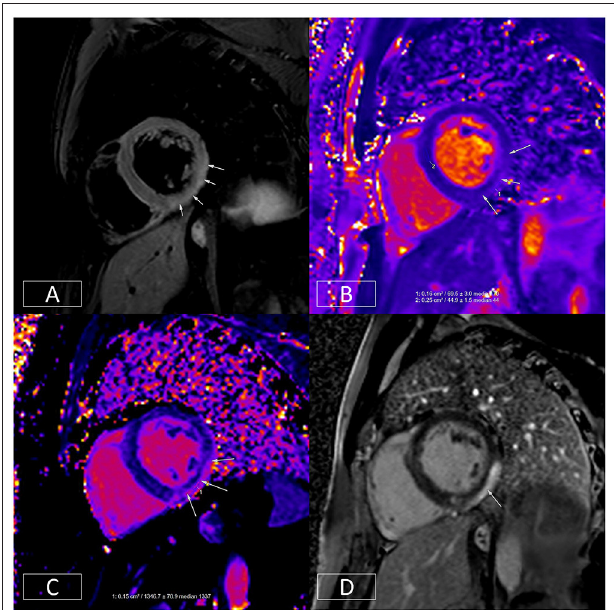
FIGURE 5 | Multiparametric evaluation of a patient with acute myocarditis. (A) Depicts increased T 2 signal in the mid-inferior and lateral walls in an epicardial to mid-wall distribution. The absolute T 2 time in the inflamed area is increased to ∼ 70ms (B) whereas the remote myocardium in the septum has a normal T 2 time of 45ms (normal < 55ms). (C) depicts increased native T 1 , another marker of tissue injury. This is raised at 1,347ms in the epicardium of the mid-inferior and lateral walls (normal range: 890–1,035ms on this platform at 1.5T). (D) illustrates epicardial to mid-wall enhancement of the mid-inferior and lateral walls, which spares the sub-endocardium (typical of